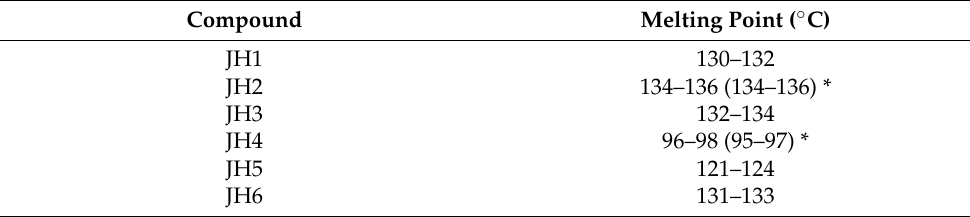
Table 1. Melting point of bis-THTTs (JH1–JH6).